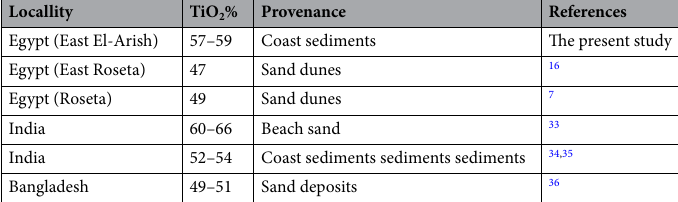
Table 4. TiO 2 % in ilmenite of different localities and provenances.